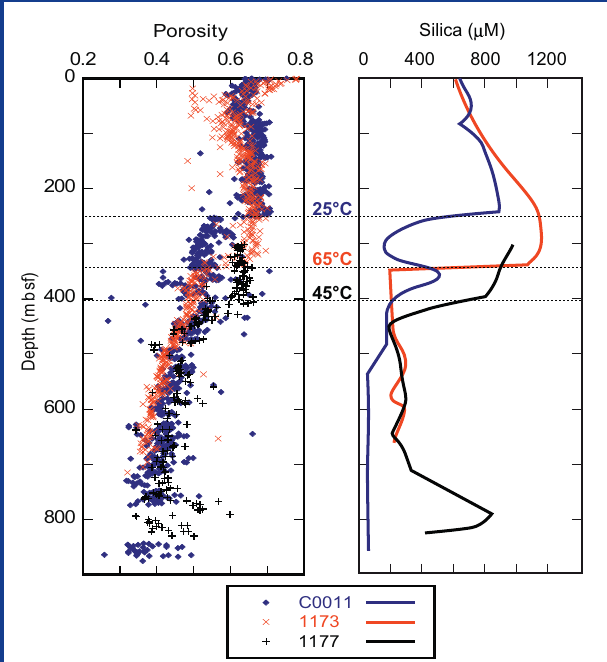
Figure 8. Porosity from sites C0011, 1173, and 1177 from moisture and density measurements, and silica concentration profiles in interstitial water. A concomitant drop of silica concentration and porosity is observed at all sites within the Shikoku Basin hemipelagites. This also correlates with a front of volcanic ash alteration. It was proposed that clay compaction is prevented by the precipitation of opal-CT cements at grain boundaries at the initial stages of diagenesis and that this metastable cement is then dissolved as temperature increases (Spinelli et al., 2007). The temperature estimated from borehole measurements at the depth of the transition is indicated. The diagenetic boundary is found at a different temperature at each site, which may help constraining the kinetics of the